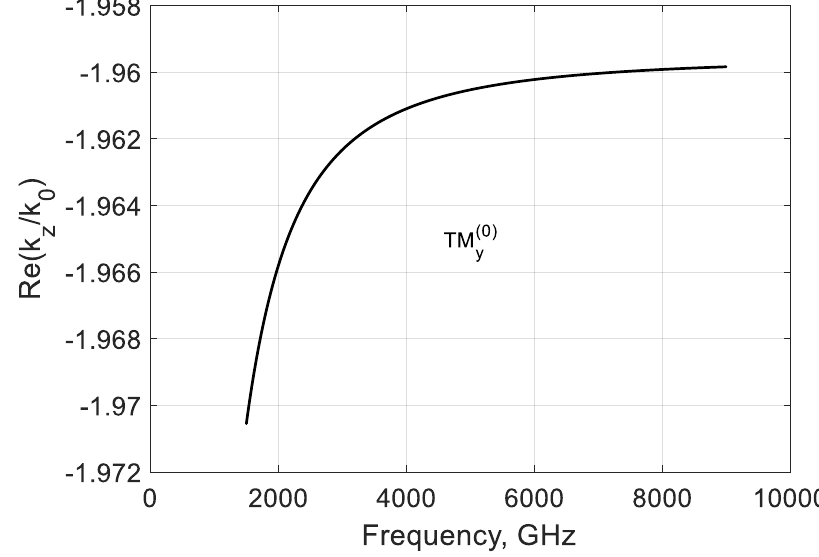
( 0 ) ( 0 ) y backward z / k 0 of the first TM